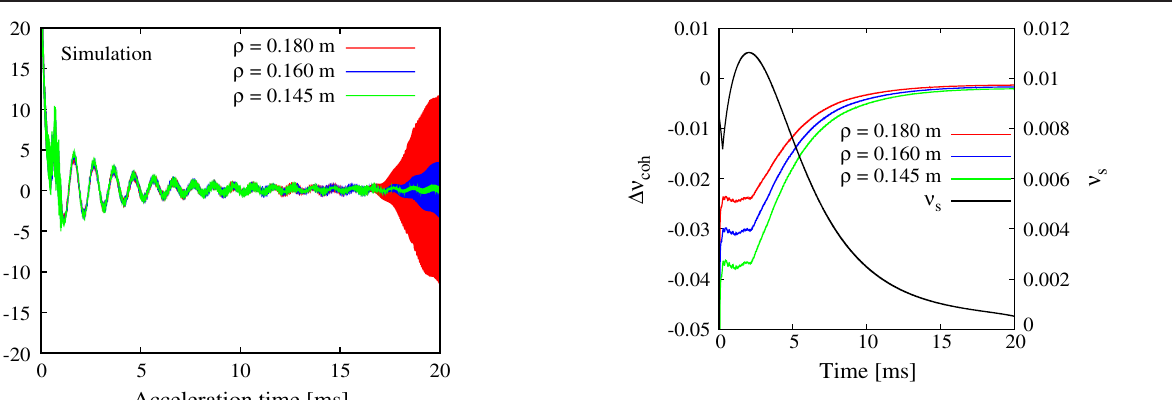
FIG. 16. Simulation results of beam instability growth depend- ence on the vacuum chamber radius ρ . The indirect space charge effect is reduced by an increase of ρ , and the beam tends to destabilize with increasing ρ .